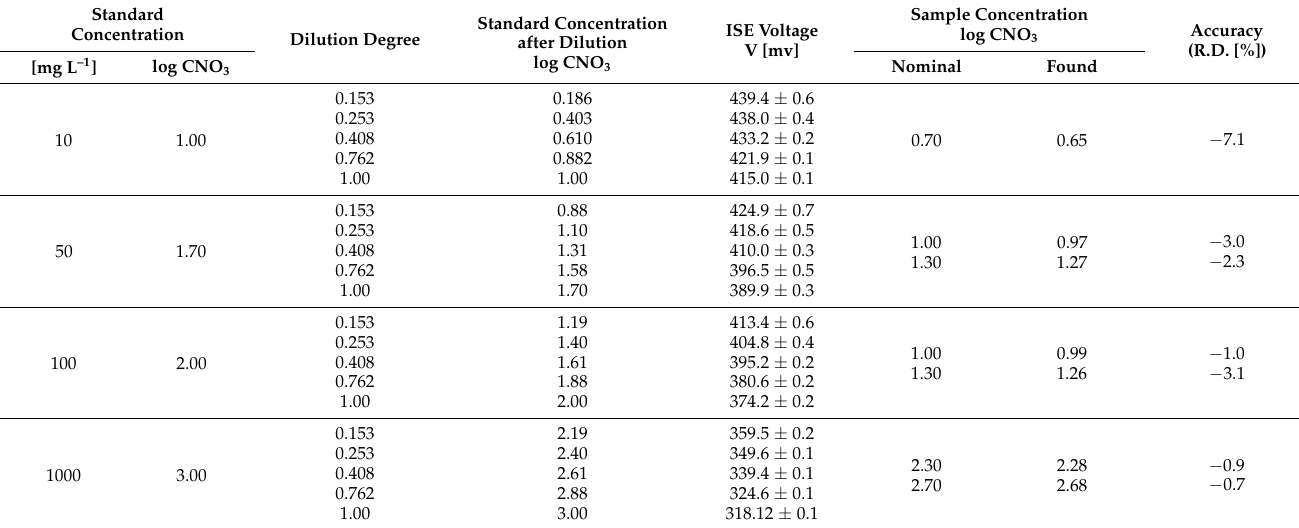
Table 2. Data on checking the calibration graphs.